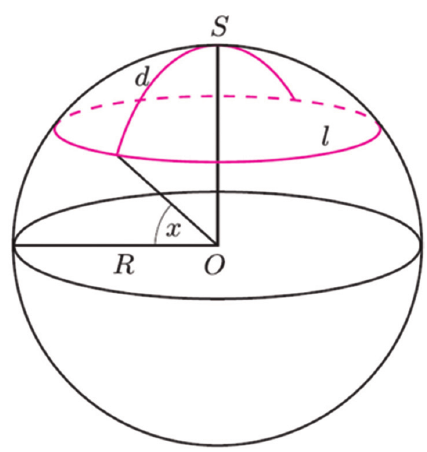
Fig. 4. The diameter of the spherical circle (Kopacz 2010)